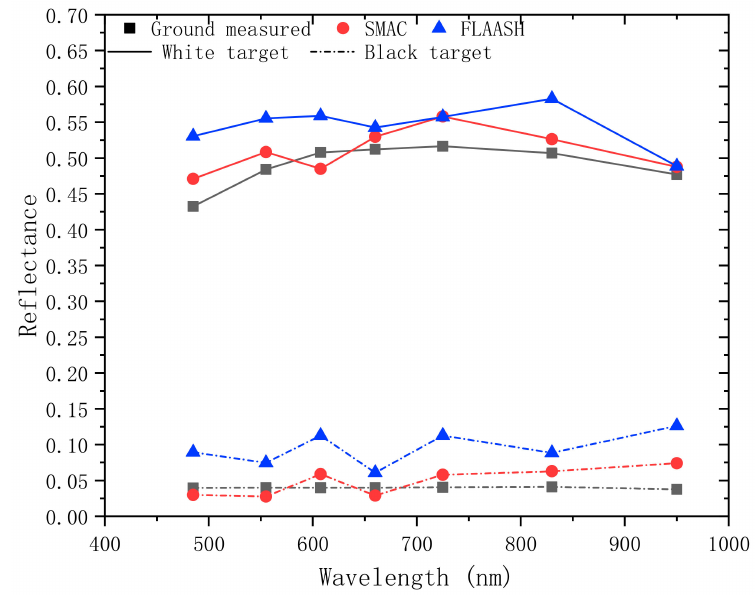
Figure 11. The average surface reflectance of white and black targets in the corrected image of